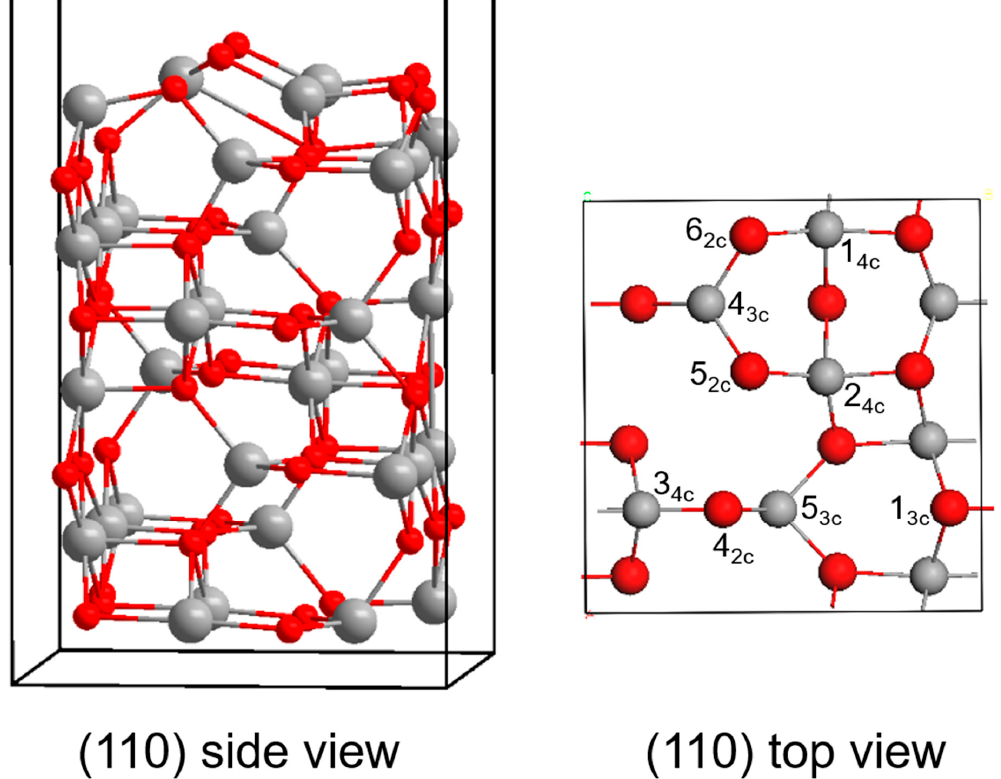
Figure 6. The side and top views of γ -Al 2 O 3 (110) surface. The red and gray balls represent the surface O and Al atoms, respectively. The surface atoms are indexed by numbers. The surface O and Al atoms coordination numbers are shown by subscript